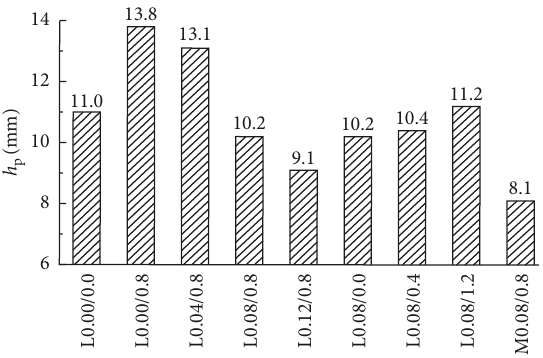
Figure 3: Test values of the height of water